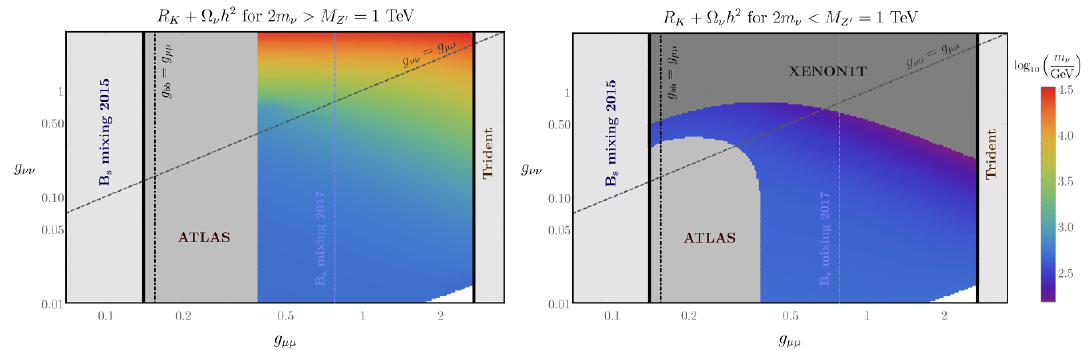
Figure 8 . Summary of the constraints for M Z 0 = 500 GeV. See text in section 5 for details.